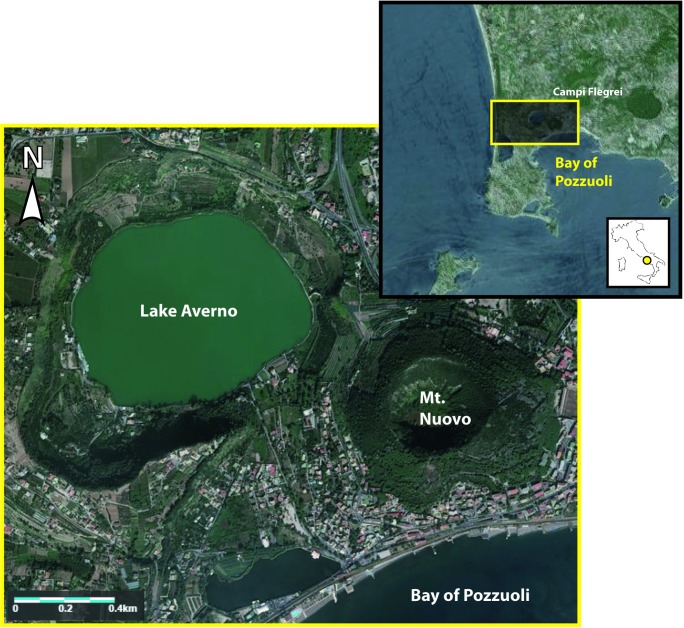
Schematic map of the Campi Flegrei caldera with the location of Lake Averno.This Figure is similar but not identical to the original image, and is therefore for illustrative purposes only.